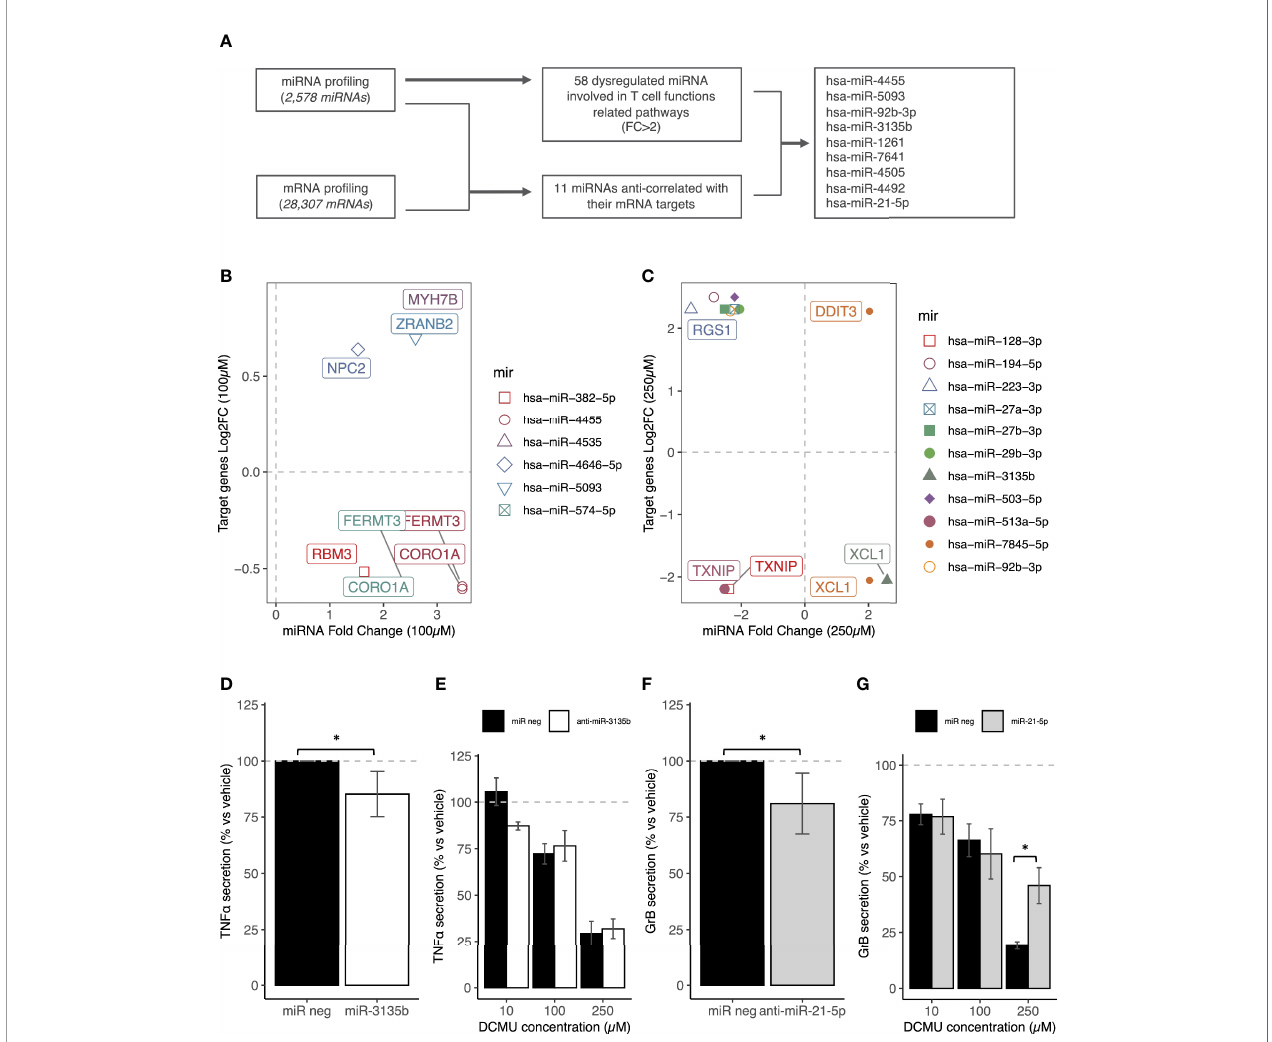
FIGURE 3 | miRNA transfections mimic DCMU- induced alterations in CD8+T cells. (A) Flowchart of the miRNA and mRNA analyses of CTL03.1 cells exposed to DCMU in order to identify candidate miRNAs. (B) Identi fi cation of the upregulated miRNAs/downregulated mRNAs and the downregulated miRNAs/upregulated mRNAs couples after an exposure to a DCMU dose of 100µM. (C) Identi fi cation of the upregulated miRNAs/downregulated mRNAs and the downregulated miRNAs/upregulated mRNAs couples after an exposure to a DCMU dose of 250µM. (D) TNF- a protein concentrations in supernatant of CTL03.1 cells transfected with a miR-3135b mimic or a negative control miRNA during 24h. (E) TNF- a protein concentrations in supernatant of CTL03.1 cells exposed to DCMU and transfected with antimiR-3135b during 24h. (F) Gr-B protein concentrations in supernatant of CTL03.1 cells transfected with an anti-miR-21-5p or a negative control miRNA during 24h. (G) Gr-B protein concentrations in supernatant of CTL03.1 cells exposed to DCMU and transfected with a miRNA-21-5p mimic during 24h. Each time 3 independent experiments were run in triplicate per condition. Statistical signi fi cance. * p ≤